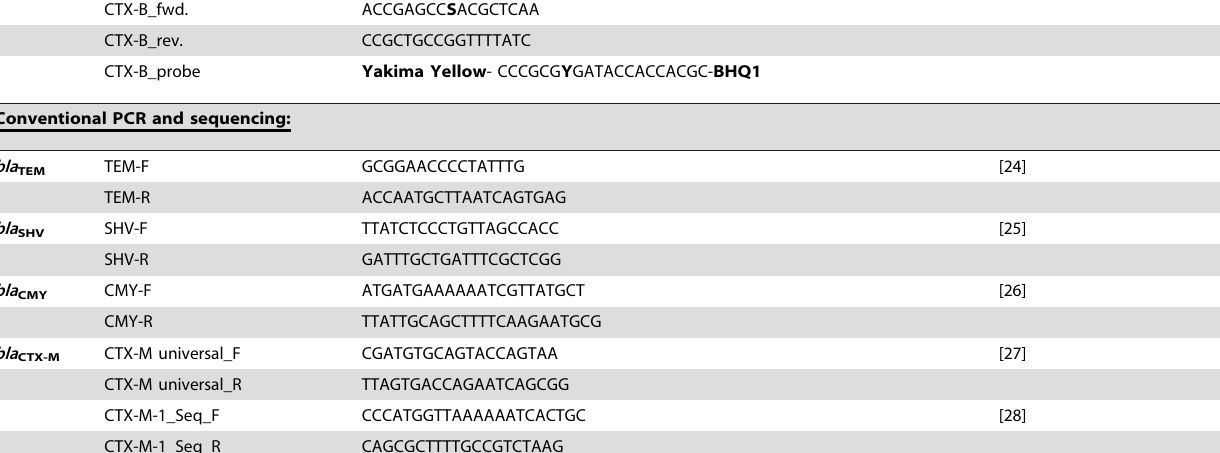
Table 3 indicates that each of the five primer/probe combina- tions showed an unambiguous detection of its reference gene. All of the fluorescence curves crossed the threshold line almost in the middle of the PCR run (between cycle 13 and 16) and no